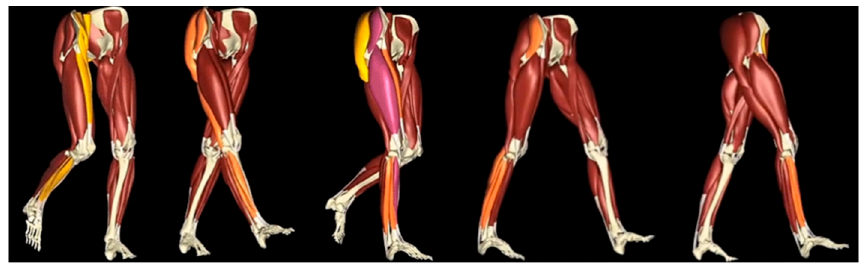
Figure 2. Schematic diagram of skeletal muscle for human lower limbs.